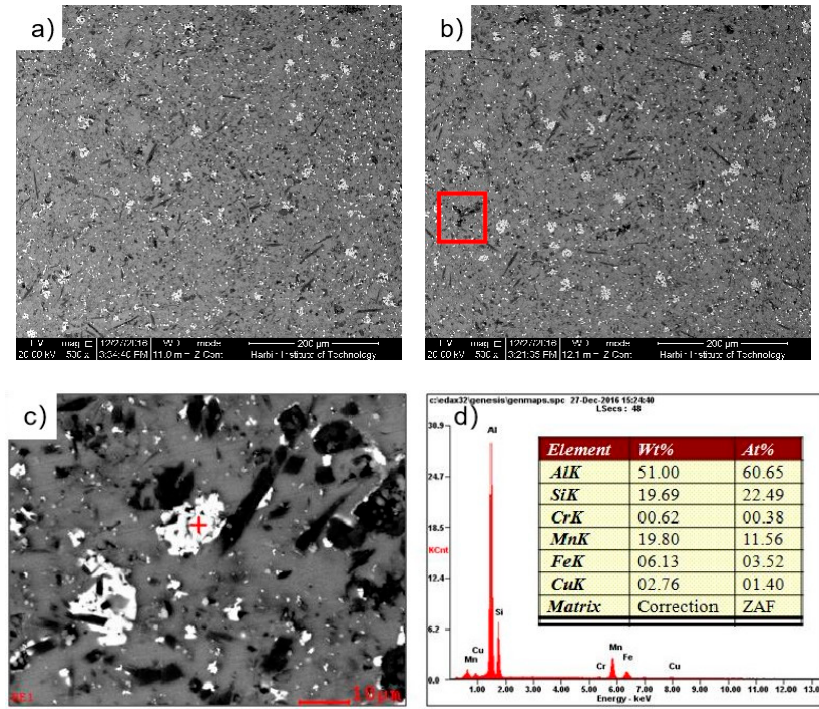
Figure 5. The SEM photograph and second phase energy spectrum of the microstructrue of the casting composite: ( a ) The horizontal microstructrue of SEM; ( b ) The vertical microstructrue of SEM; ( c ) The large second phase in matrix; ( d ) The energy spectrum of large second